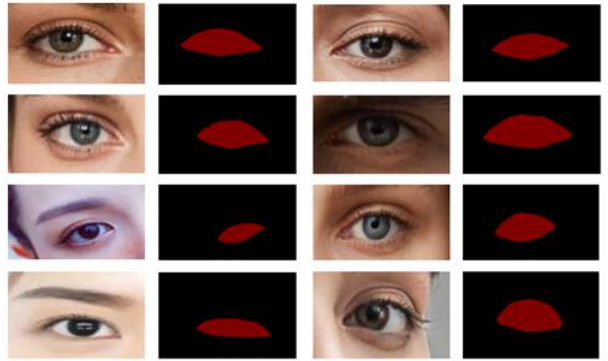
Figure 8. Original image of the left and right eyes and the sample data of annotated images. Figure 9 shows the labeled left and right eye images in the dataset. Labeling fits the outer contours of the eyes and completely encloses the external shape. All images were checked for labels to reduce labeling errors and create an accurate dataset. In a total of 3000 eye images, we allocated 1500 for the left eyes and the right eyes equally.